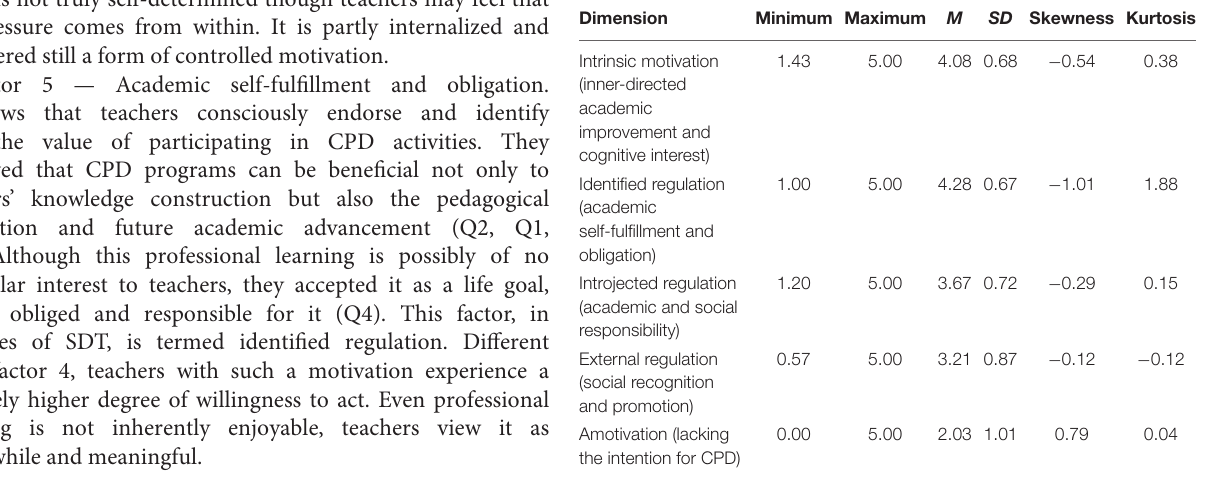
TABLE 3 | Distributive statistics for TEFL teachers’ CPD